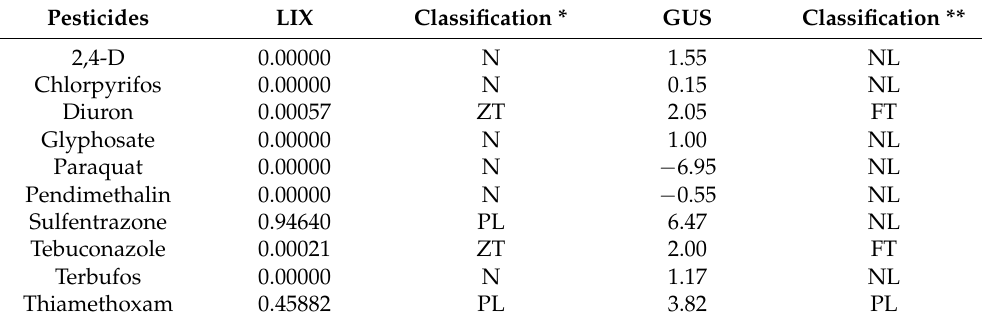
Table 2. Potential risk of agrochemical leaching into soil evaluated by the LIX and GUS methods. Pesticides LIX Classification * GUS Classification ** 2,4-D 0.00000 N 1.55 NL Chlorpyrifos 0.00000 N 0.15 NL Diuron 0.00057 ZT 2.05 FT Glyphosate 0.00000 N 1.00 NL Paraquat 0.00000 N − 6.95 NL Pendimethalin 0.00000 N − 0.55 NL Sulfentrazone 0.94640 PL 6.47 NL Tebuconazole 0.00021 ZT 2.00 FT Terbufos 0.00000 N 1.17 NL Thiamethoxam 0.45882 PL 3.82